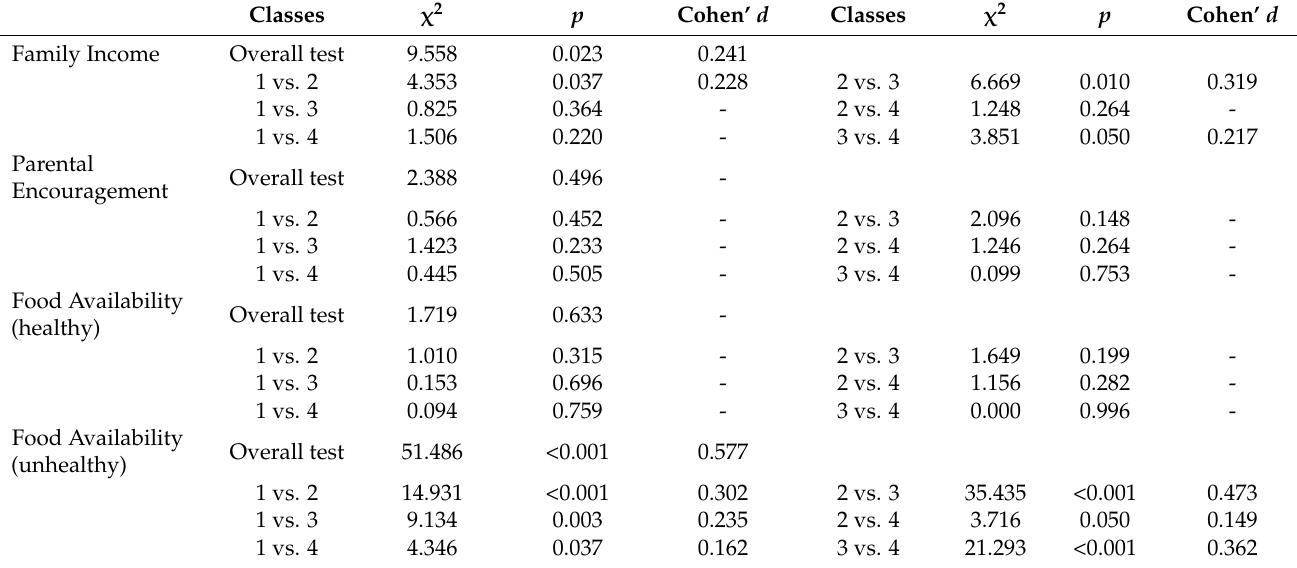
Table 5. Relationship between diet profiles and outcome